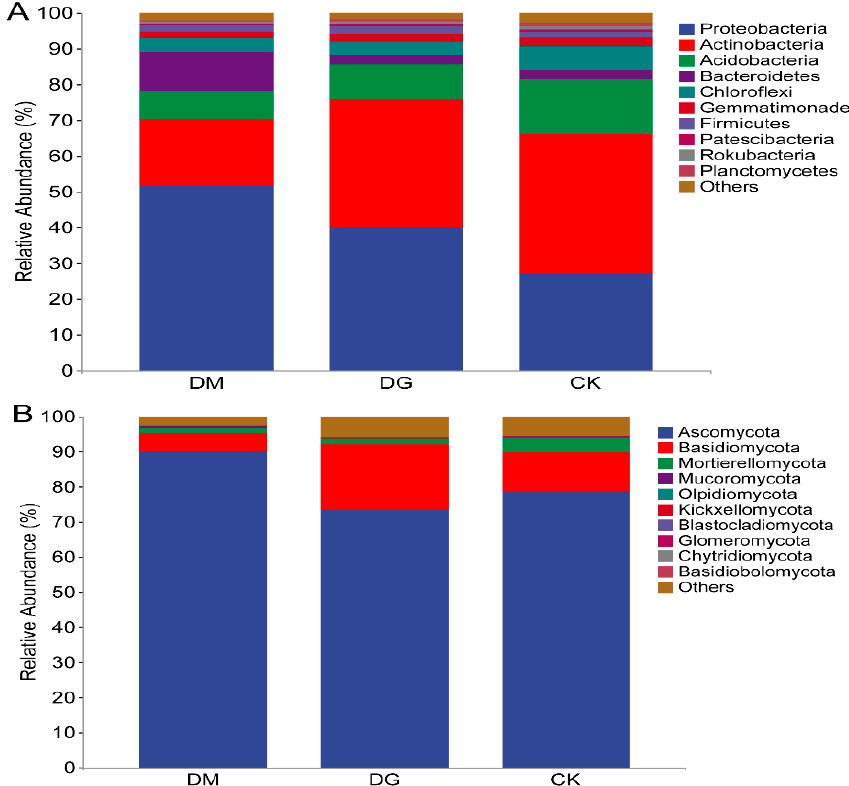
Figure 3. Phylum levels of the top 10 bacteria ( A ) and fungi ( B ) in terms of average relative abun- dance.